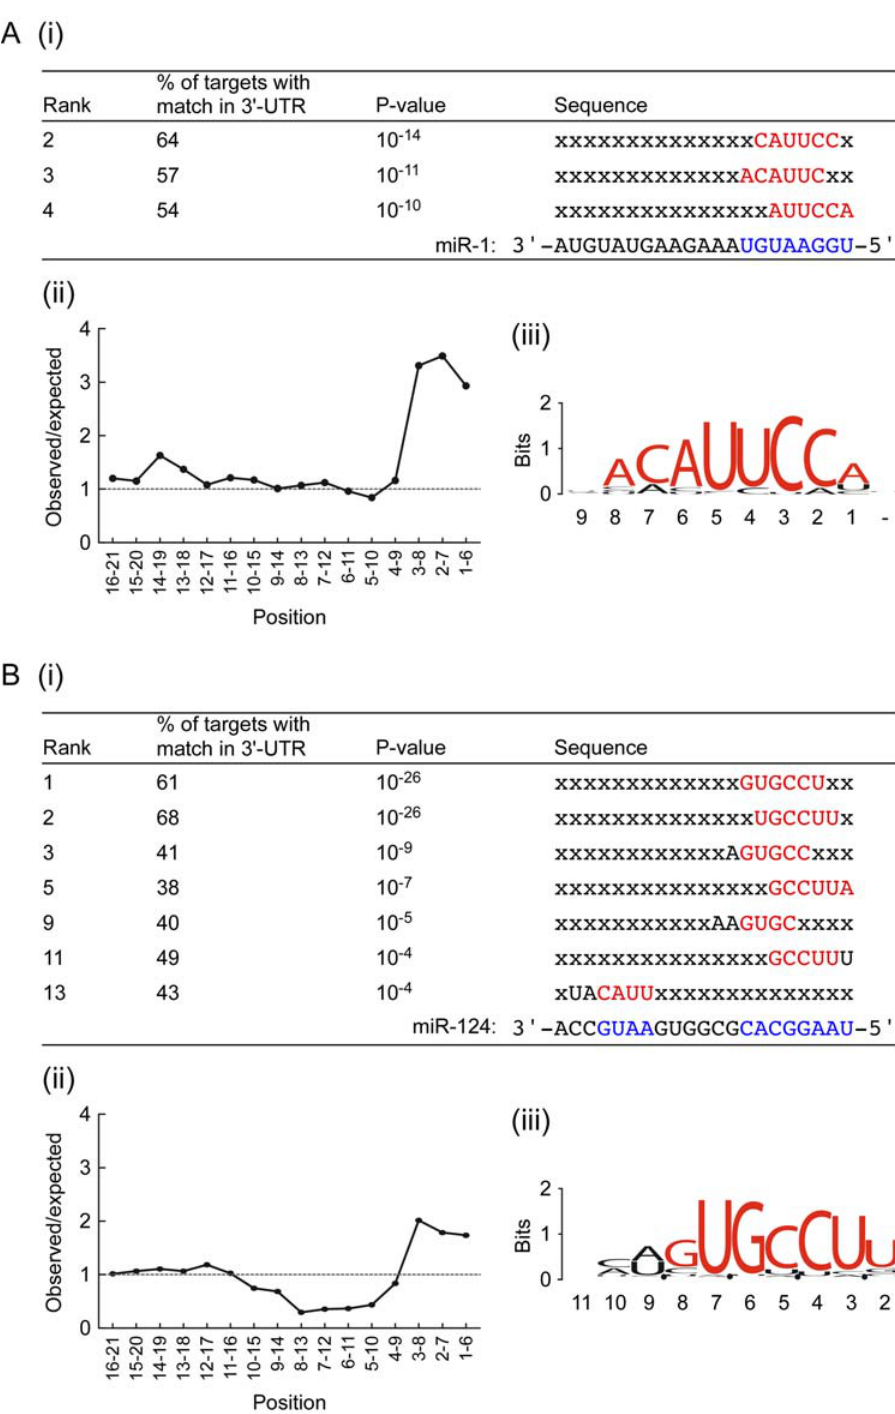
Figure 4. Significantly enriched motifs in 3 9 -UTRs of mRNAs targeted to Ago2 by miR-1 and miR-124. (A) Analysis of mRNAs associated with Ago2 from cells transfected with FLAG-Ago2 and miR-1 relative to cells transfected with Ago2 alone (1% local FDR). (i) Enrichment of hexamers in 3 9 -UTRs of miR-1 IP targets compared to 3 9 -UTRs of all mRNAs passing array filters. Shown are hexamers with at least four contiguous Watson-Crick base pairs to miRNA with a p-value cut-off of 0.001 (binomial test with bonferroni correction). Rank by p-value relative to all 4096 hexamers. Bases in red can form Watson-Crick base pairs with miR-1. (ii) Moving plot of observed/expected ratios of hexamers complementary to miR-1. Frequencies calculated as in (i). (iii) 10mer motif returned by MEME motif finder using 3 9 -UTR sequences from the miR-1 high confidence target set. For each position in the motif, the combined height of the bases represents the information content at that position, whereas the relative heights of the individual bases represent the frequency of that base at that position. Bases in red can form Watson-Crick base pairs with miR-1. Numbers underneath the logo correspond with miRNA 5 9 -position, with 1 being the 5 9 -most miRNA nucleotide. (B) Same as in (A), except for mRNAs associated with Ago2 from cells transfected with FLAG-Ago2 and miR-124 relative to cells transfected with Ago2 alone.